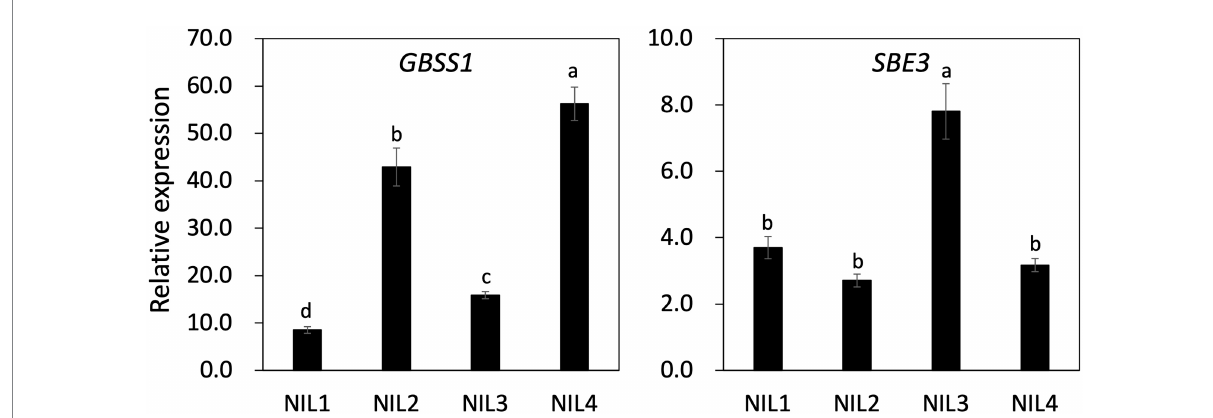
FIGURE 5 Gene expression of GBSS1 and SBE3 in four NILs using panicles samples from 15 days after flowering. UBQ5 was used for gene normalization. The same letter on the bar is not significantly different at p < 0.05 based on Tukey’s test,